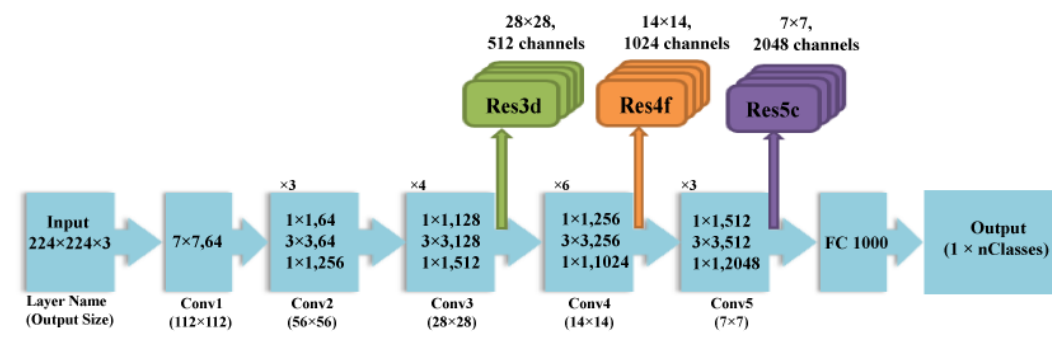
Figure 2 . The structural design of ResNet 50 CNN. Figure 2. The structural design of ResNet 50 CNN.